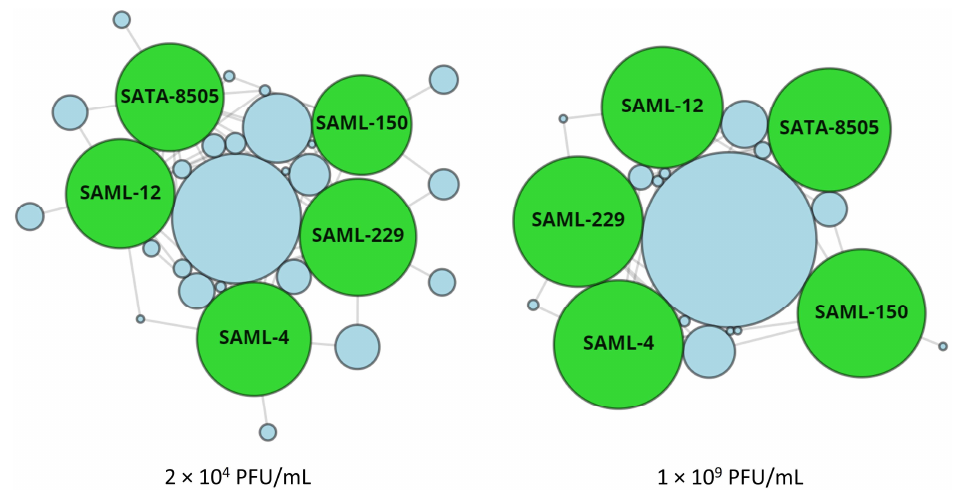
Figure 3. Visualization of the lytic spectrum of StaphLyse™ at two concentrations. Shown is a force-directed graph depicting the host-killing range and interaction network of the 5 monophages included in StaphLyse™ generated by the proprietary PhageSelector™ program (Intralytix, Inc., Columbia, MD, USA). Monophages are represented by green nodes, which are sized based on the total strains each kills. Blue nodes are collections of S. aureus strains. Lines connecting green nodes to blue nodes indicate a monophage that is capable of lysing the strains from a node at a given con- centration. Blue nodes that are larger in size and are clustered closer to the center of the figure indi- cate that a greater number of strains are being lysed by multiple phages (i.e., redundant lytic spec- trum coverage), whereas smaller nodes that are clustered closer to the edges of the figure indicate that a smaller number of strains are susceptible to fewer monophages.